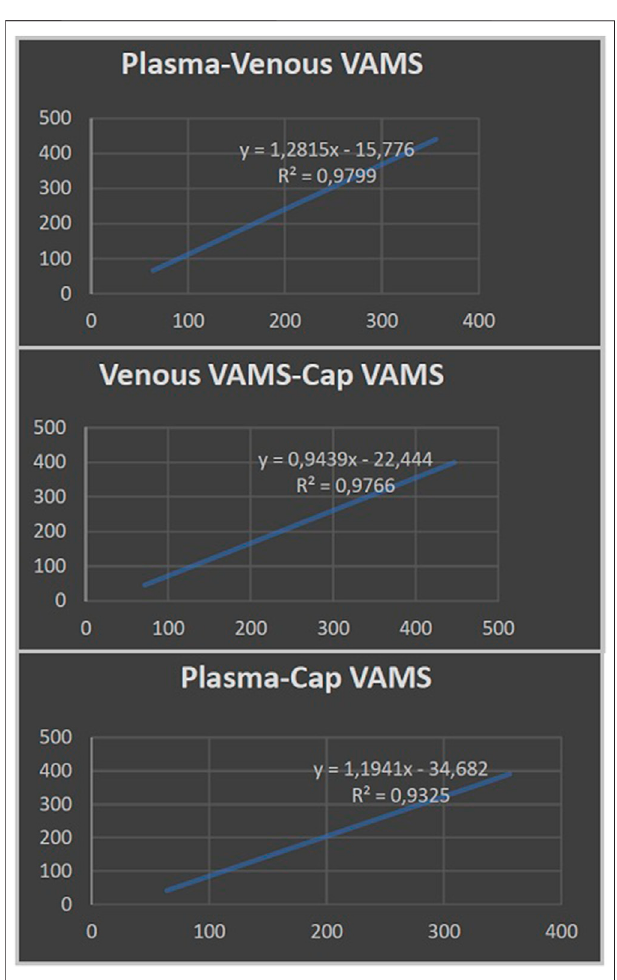
FIGURE 1 | Linear regression analysis showing the correlation between cannabidiol plasma levels from venipuncture and cannabidiol concentrations measured by venous and capillary volumetric absorptive microsampling